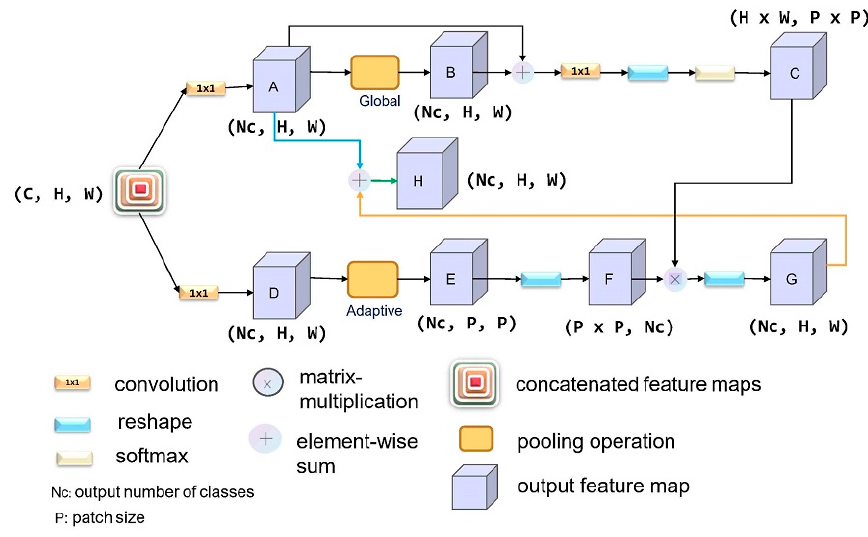
Figure 5. Illustration for the architecture of CRAM.